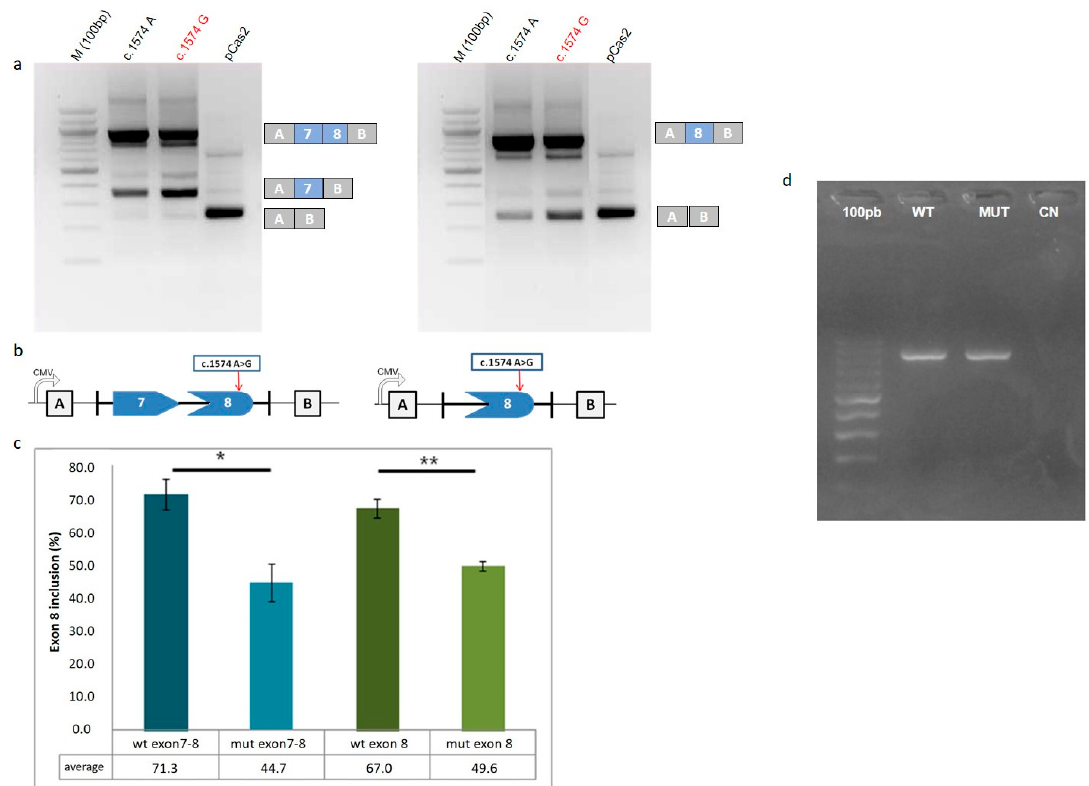
Figure 1. CLSPN c. 1574A>G variant increases the probability of exon 8 skipping in vitro. pCAS2 empty vector (pCAS2) or pCAS2 constructs carrying exonic fragments with CLSPN c.1574A>G variant were transfected in HeLa cells. Total RNA was extracted 24 h after transfection and RT-PCR was performed. RT-PCR products were separated on a 2% agarose gel stained with ethidium bromide and visualized under UV light. ( a ) CLSPN c.1574A>G leads to exon 8 skipping, both in single (exon 8) and double exon (exon 7 and 8) minigene constructs. The identities of the RT-PCR products are indicated on the right. ( b ) Schematic representation of minigene splicing reporter vector. Exon 7 + 8 or exon 8 were inserted into pCAS2 vector. The arrow indicates the position of the variant. ( c ) Quantity One analysis software was used to quantify RT-PCR bands and assess exon 8 inclusion, both in the WT and mutant forms of the double and single minigene structures. Mean+SD of exon 8 inclusion were calculated for each minigene. The graphic shows the average percentages of exon 8 inclusion obtained in three independent experiments. Statistical analysis of the results was performed using Student’s t Test. ( d ) CLSPN c.1574A>G is not associated with the production of aberrantly spliced transcripts in HeLa cells. Electrophoretic profile obtained after RT-PCR analysis of RNA from HEK293 (WT) and HeLa (MUT) (heterozygous for CLSPN c.1574A>G) cells. Only the expected RT-PCR amplicon (822 bp) was obtained for both the WT and mutant samples. A 100 bp DNA ladder was used (100 bp); CN, negative control. The image displayed represents one of the three experiments performed. * p < 0.05; ** p < 0.001. Detailed information about western blot can be found at Figure S1.